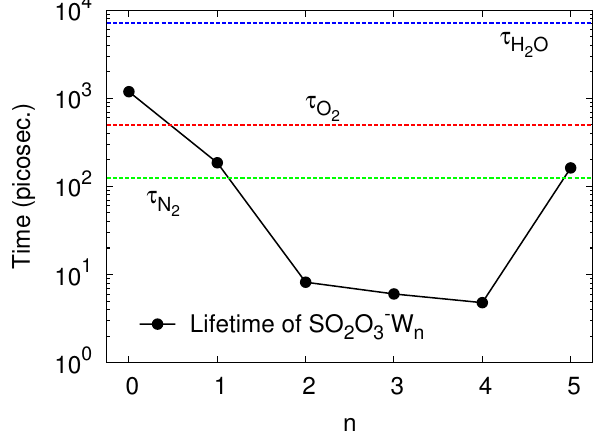
SO 2 ( H 2 O ) n at stan- 3